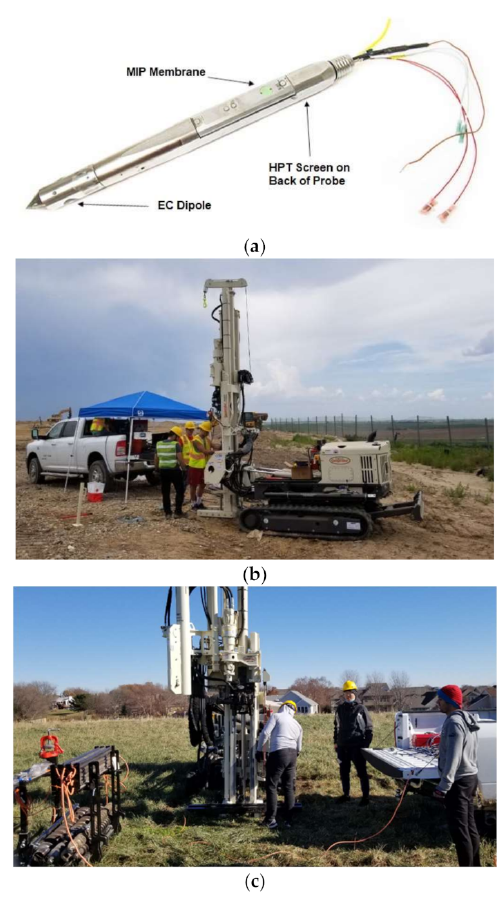
Figure 1. ( a ) Hydraulic profiling tool (HPT) and membrane interface probe (MIP) probe (Geo- probe.com); ( b ) drilling rig at the Butler County landfill; ( c ) drilling at the Sarpy County landfill. EC: electrical